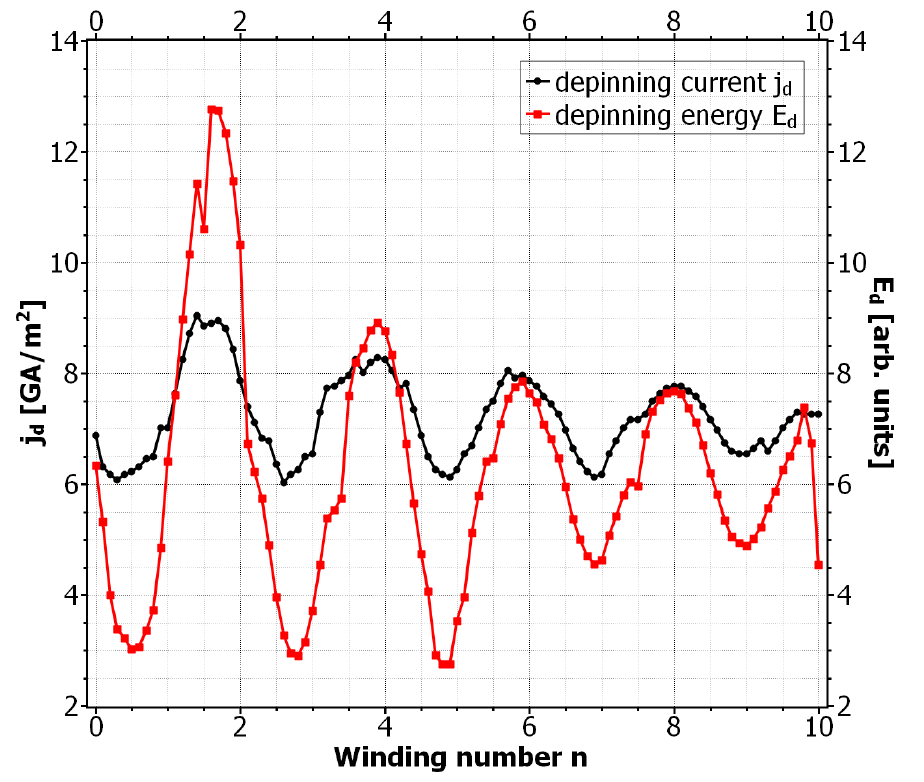
Figure 6. Depinning current and corresponding energy for B e = 1.5mT, α = α s , α 0 = 0.1¯ h / ξ GL , and j e = 7.07GA/m 2 e y . The depinning energy E d corresponds to the energy barrier for the vortex entry since the permanent vortex motion was always observed to be triggered by a vortex entry event.